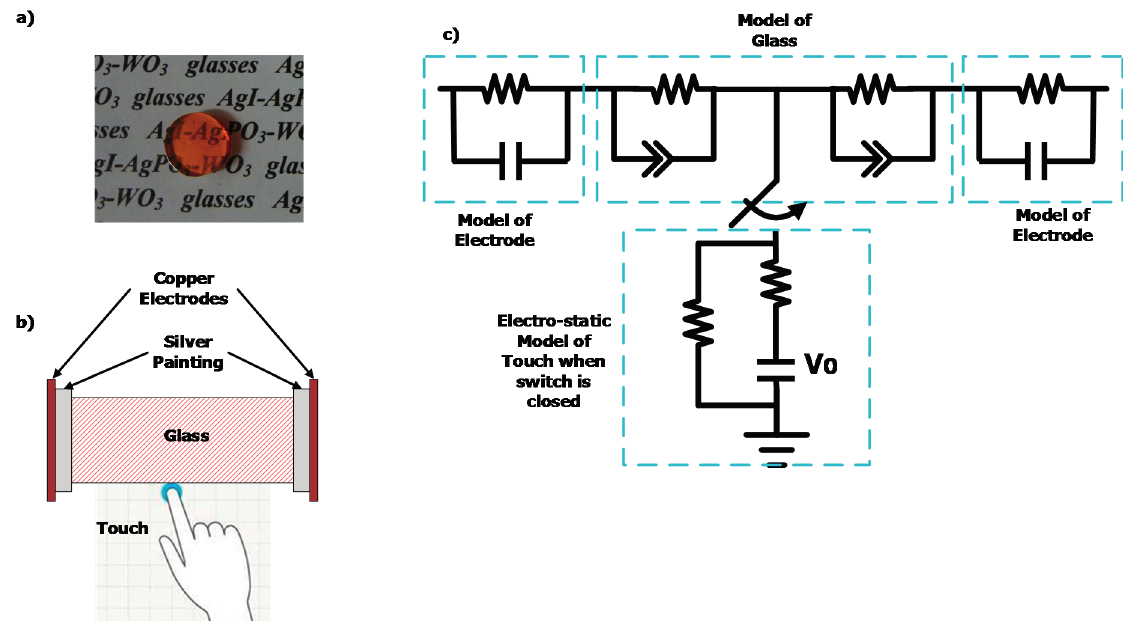
Figure 8. ( a ) Picture of the 45AgI-(55- x )AgPO 3 - x WO 3 glass sample with x = 15 mol%; ( b ) Representation of the glass touchscreen setup, wherein the copper electrodes were connected to the DIS platform; and ( c ) equivalent electro-static circuit of the AgI-AgPO 3 -WO 3 glass